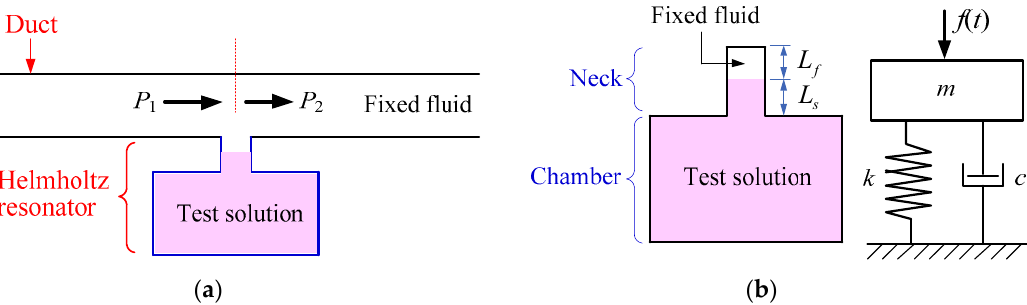
Figure 1. ( a ) The Helmholtz resonator linked with a duct; ( b ) Structure of Helmholtz resonator and its equivalent mass-spring model.